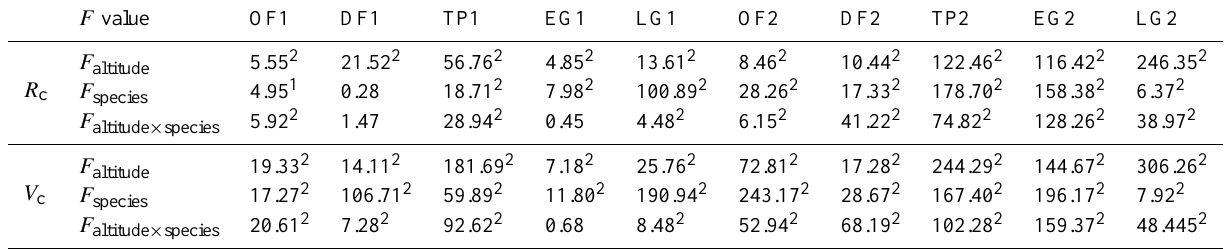
Table 2. F values derived from statistical analyses expressed as the effects of altitude, species and their combined interaction of altitude and species on R c (carbon release rate) and V c (carbon release rate per day) for each decomposition stage.